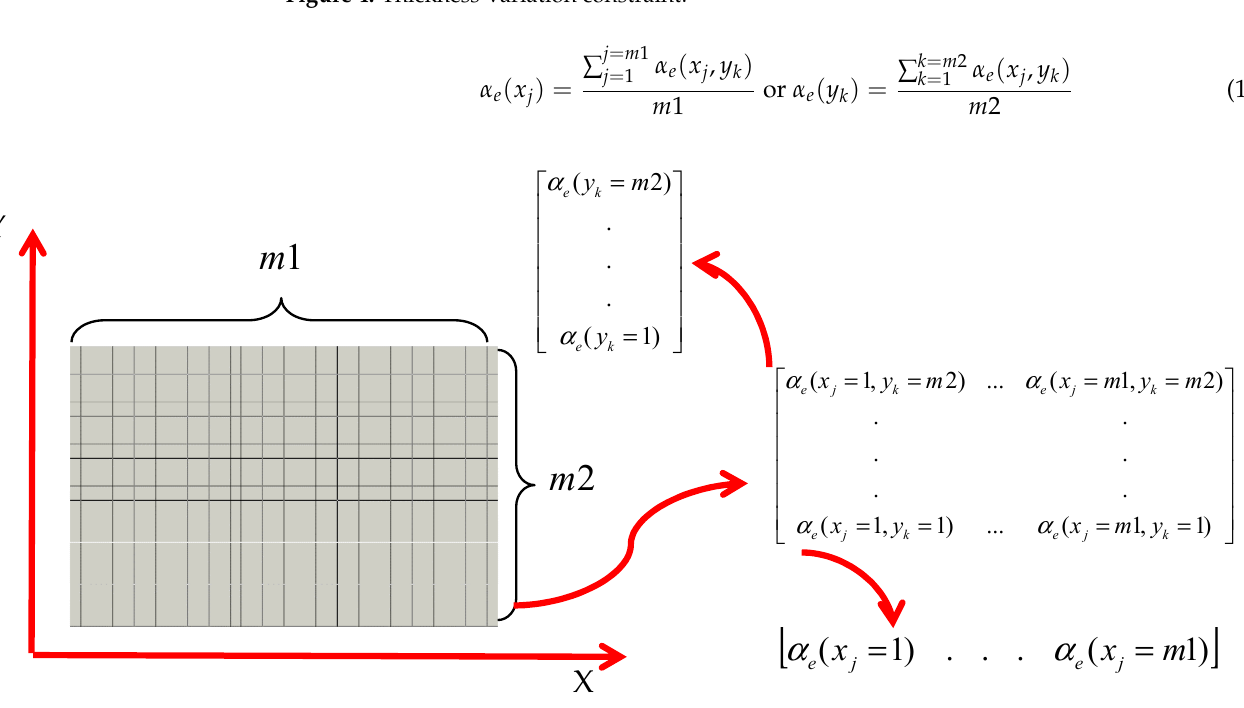
Figure 5. Thickness-sensitivity constraint.